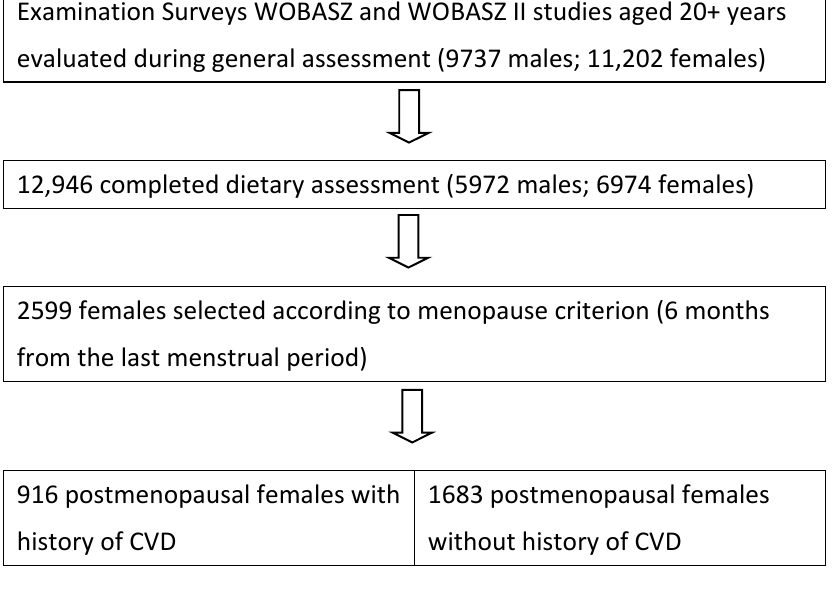
Figure 1. Flow-chart of study participants. CVD: cardiovascular disease.